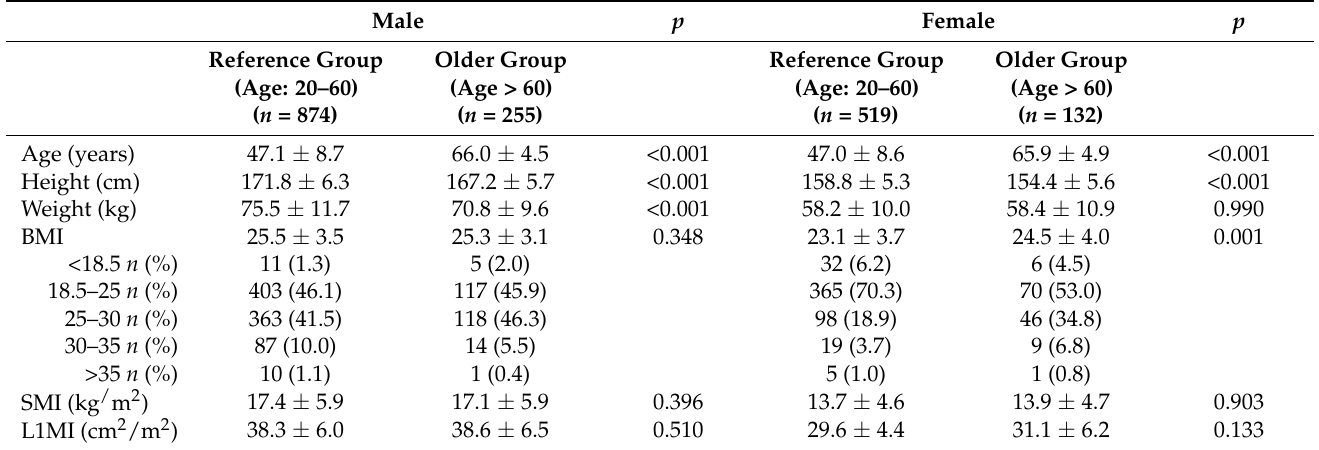
Table 2. The characteristics of gender-specific reference and older groups.